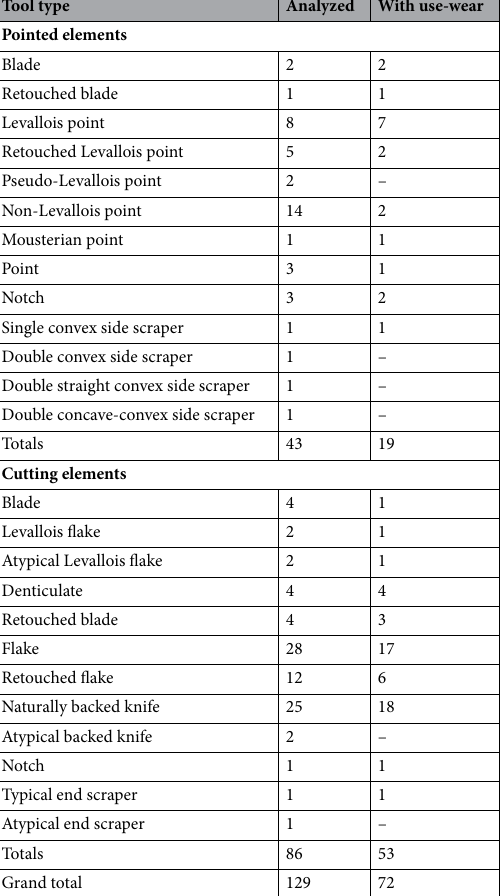
Table 2. Artifacts of NMO layer 4b selected for the functional study based on the two morphological groups identified in the assemblage and subdivided by typological categories, along with the number of artifacts that showed